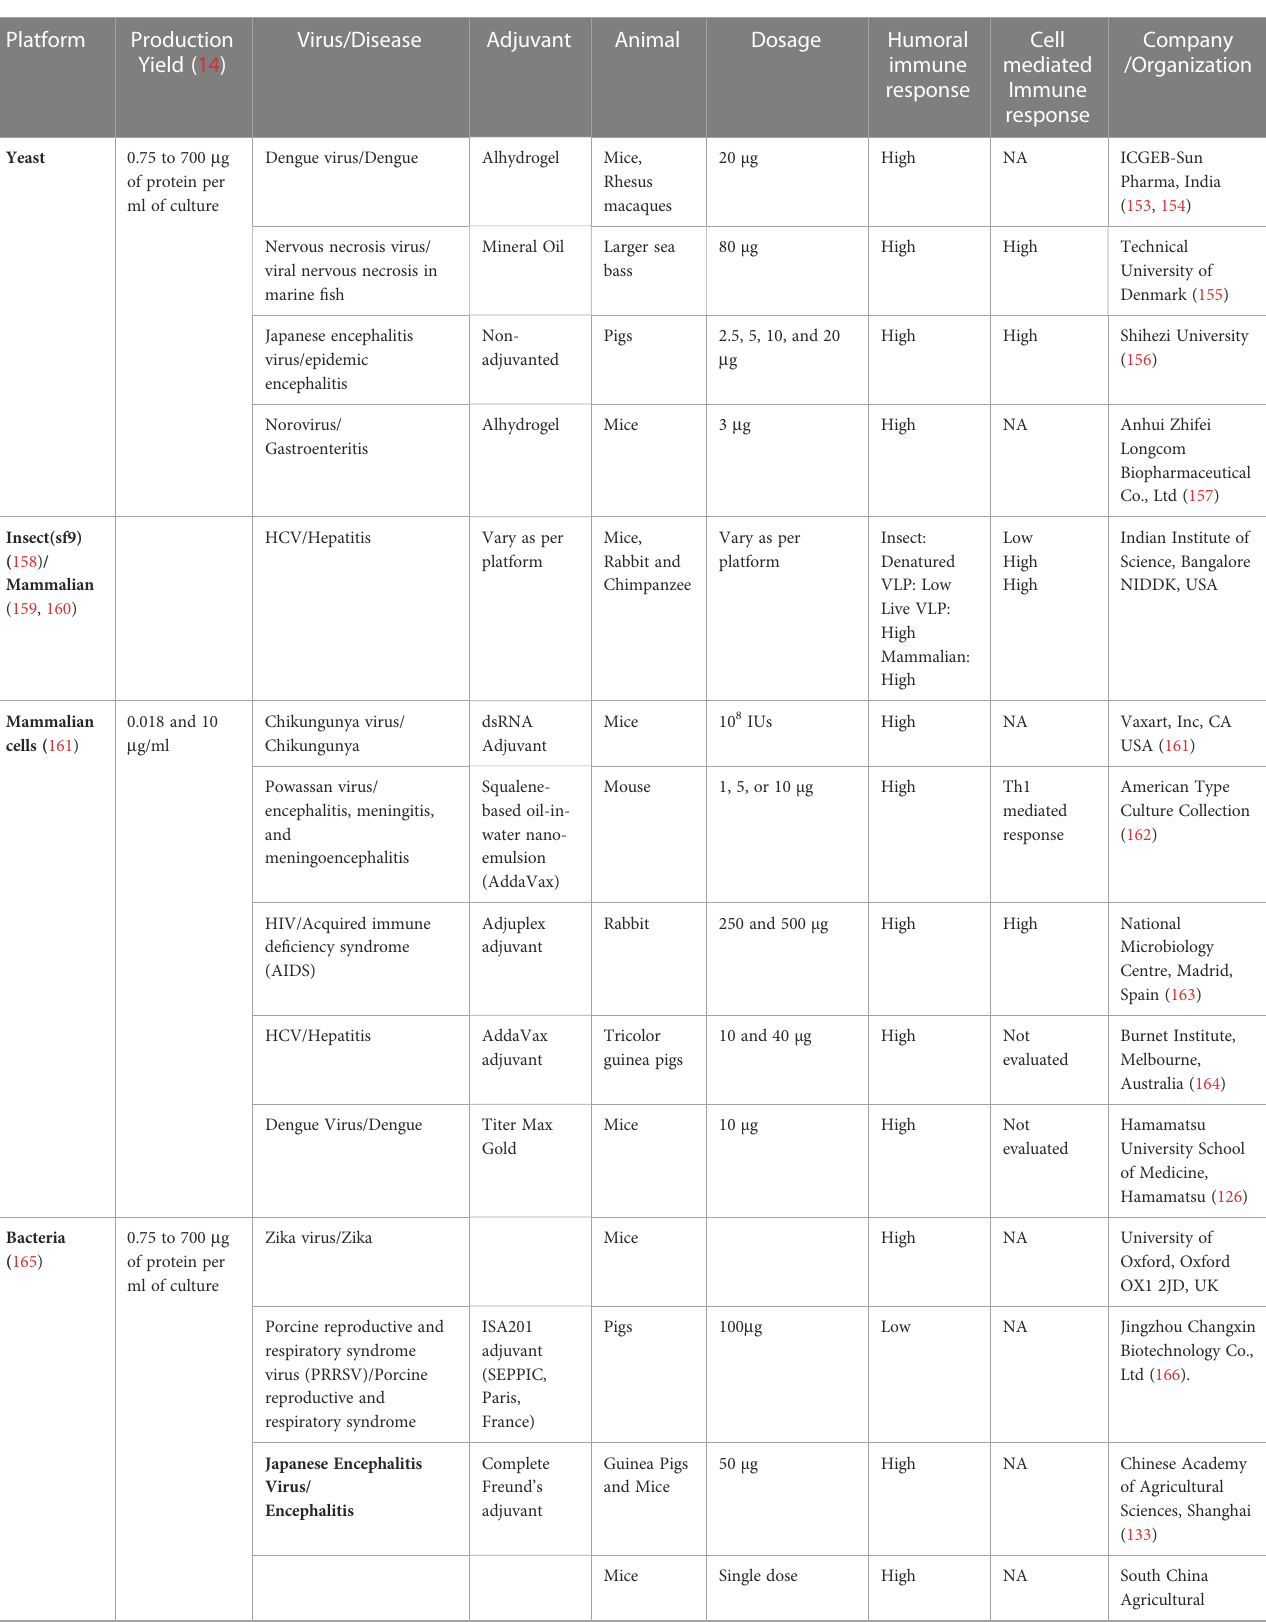
TABLE 5B VLP based vaccines at the preclinical